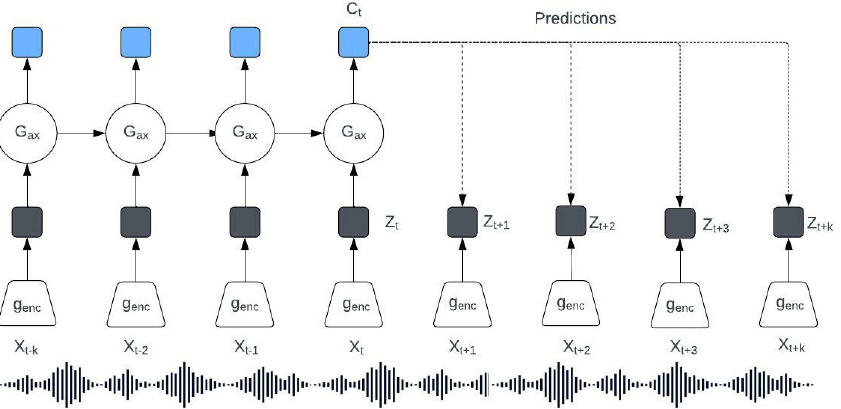
Figure 2. Generation architecture for